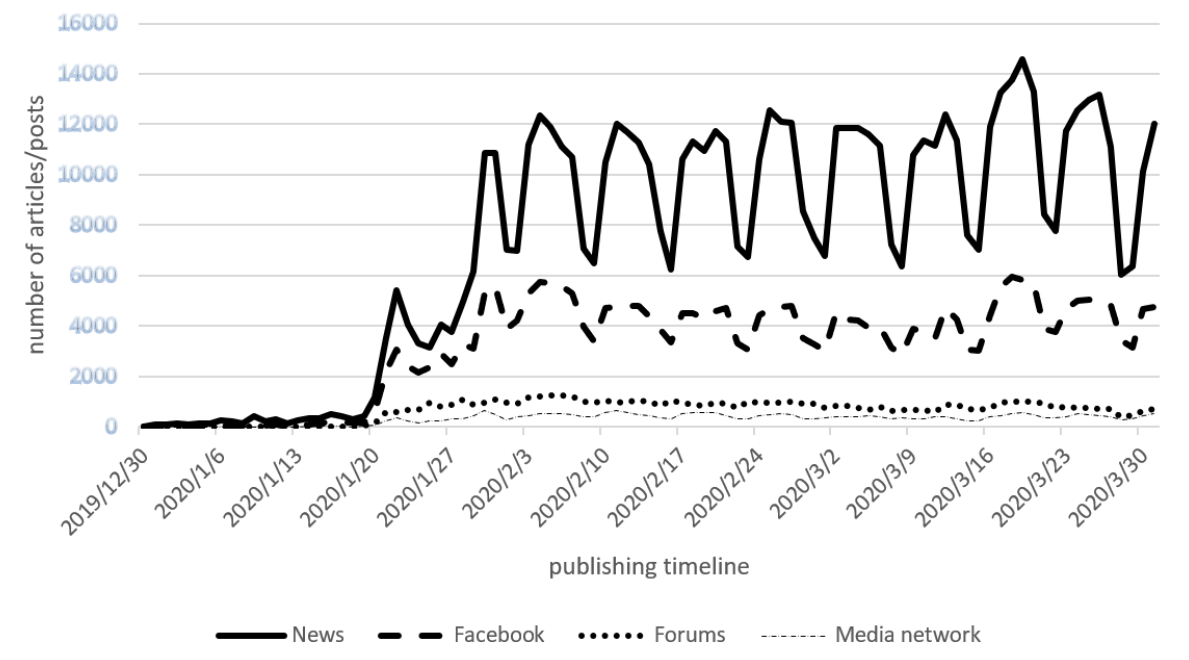
Figure 1. The intensity of communication about COVID-19 in social media and news